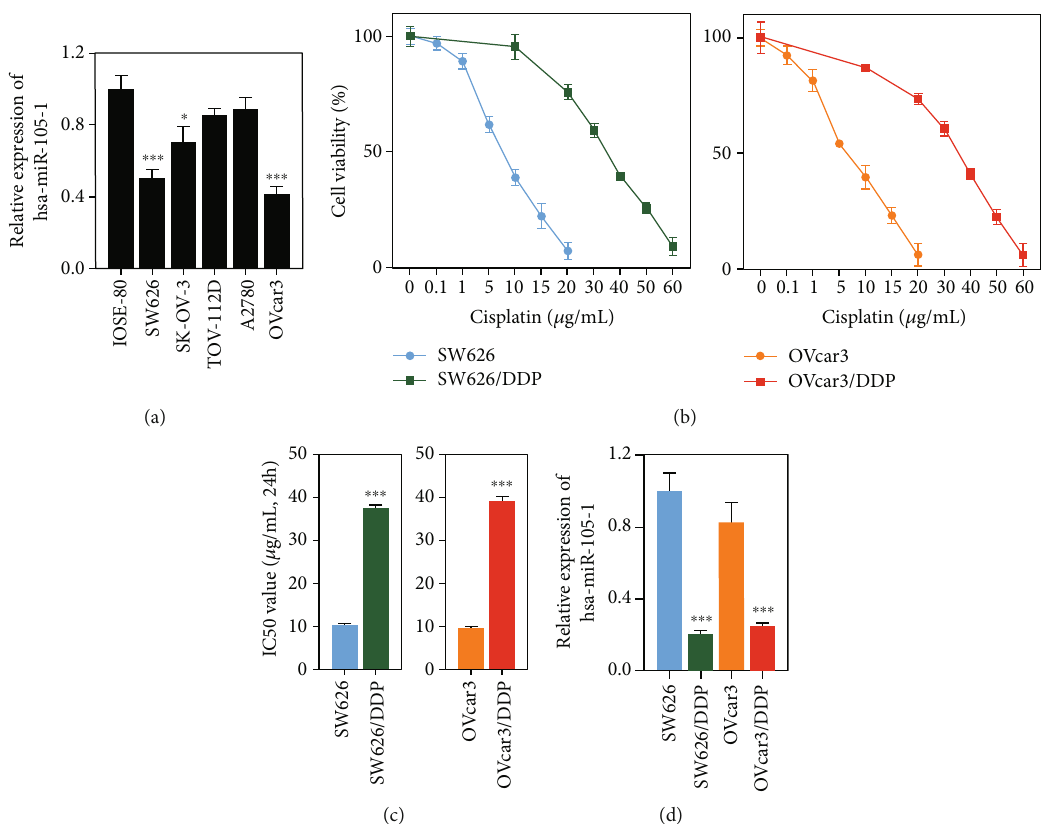
Figure 1: Hsa-miRNA-105-1 was abnormally expressed in cisplatin-resistant cell lines. (a) The levels of Hsa-miRNA-105-1 expression in a normal ovarian epithelial cell line (IOSE-80) and fi ve OC cell lines (SW626, SK-OV-3, TOV-112D, A2780, and OVcar3). (b) The viability of cisplatin-sensitive and cisplatin-resistant cells when exposed to di ff erent cisplatin concentrations. (c) The IC cisplatin-resistant cells treated with cisplatin. (d) The levels of hsa-miRNA-105-1 expression in wild type and cisplatin-resistant cells. n = 3 , ∗ P < 0 : 05 , ∗∗∗ P < 0 : 01 , and paired t